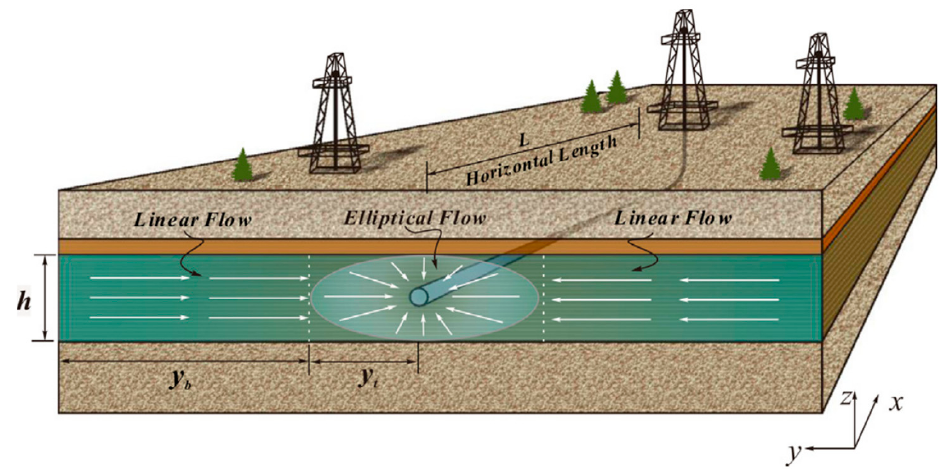
Figure 1. Horizontal well schematic.